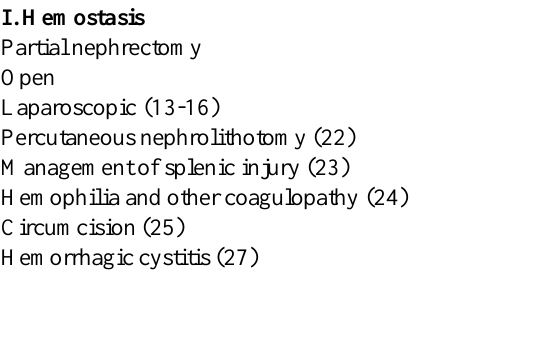
Table 2 – Urological applications of fibrin